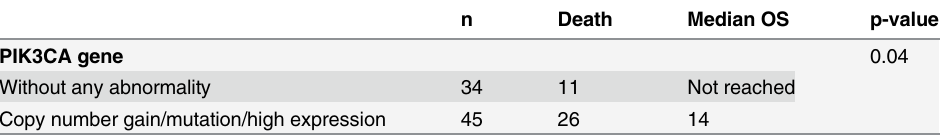
Table 7. Association of PIK3CA gene abnormality and